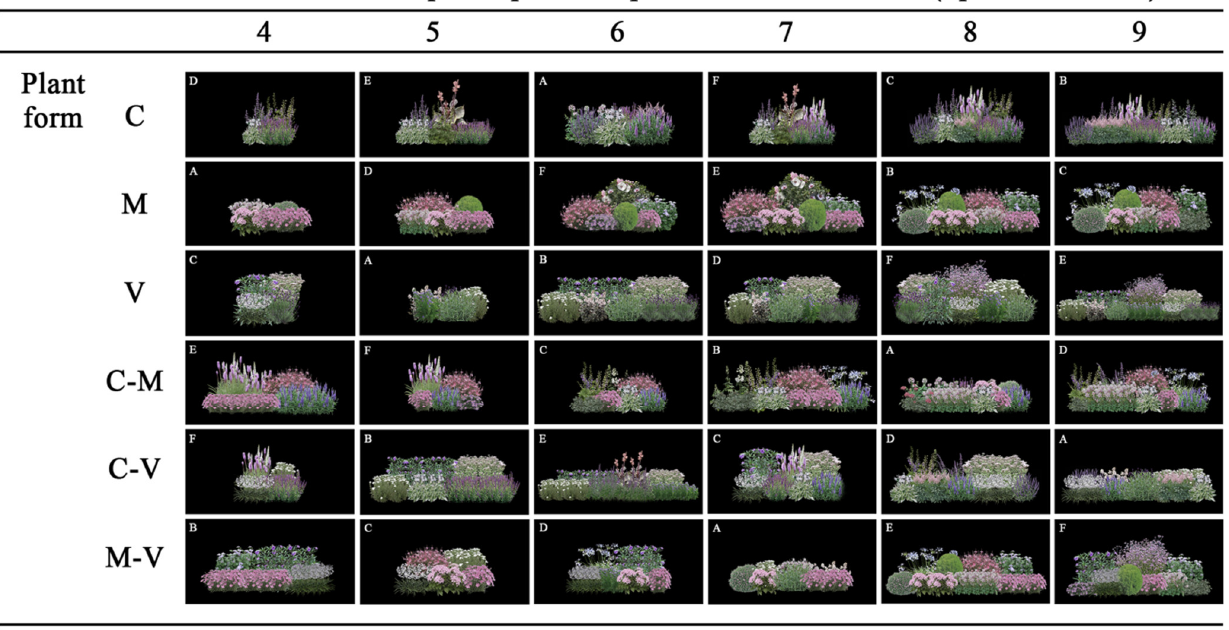
Figure 2. Visual stimuli (perennials landscape photomontages) utilized in experiment A. C, M and V represent conical, mounding and vertical, respectively. The letters in the upper left corner of each photomontage represent the plant arrangement patterns in Figure 1.